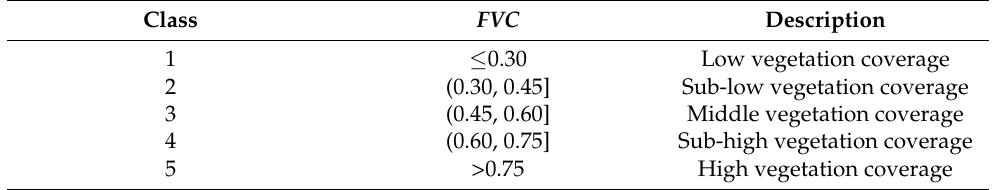
Table 1. FVC Level Classification.